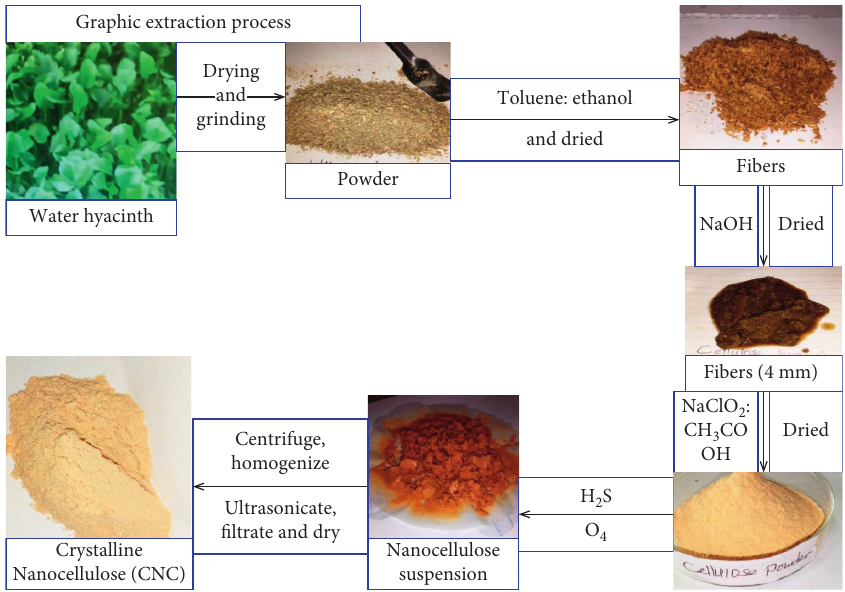
Figure 1: Flowchart of CNC preparation from Eichhornia crassipes